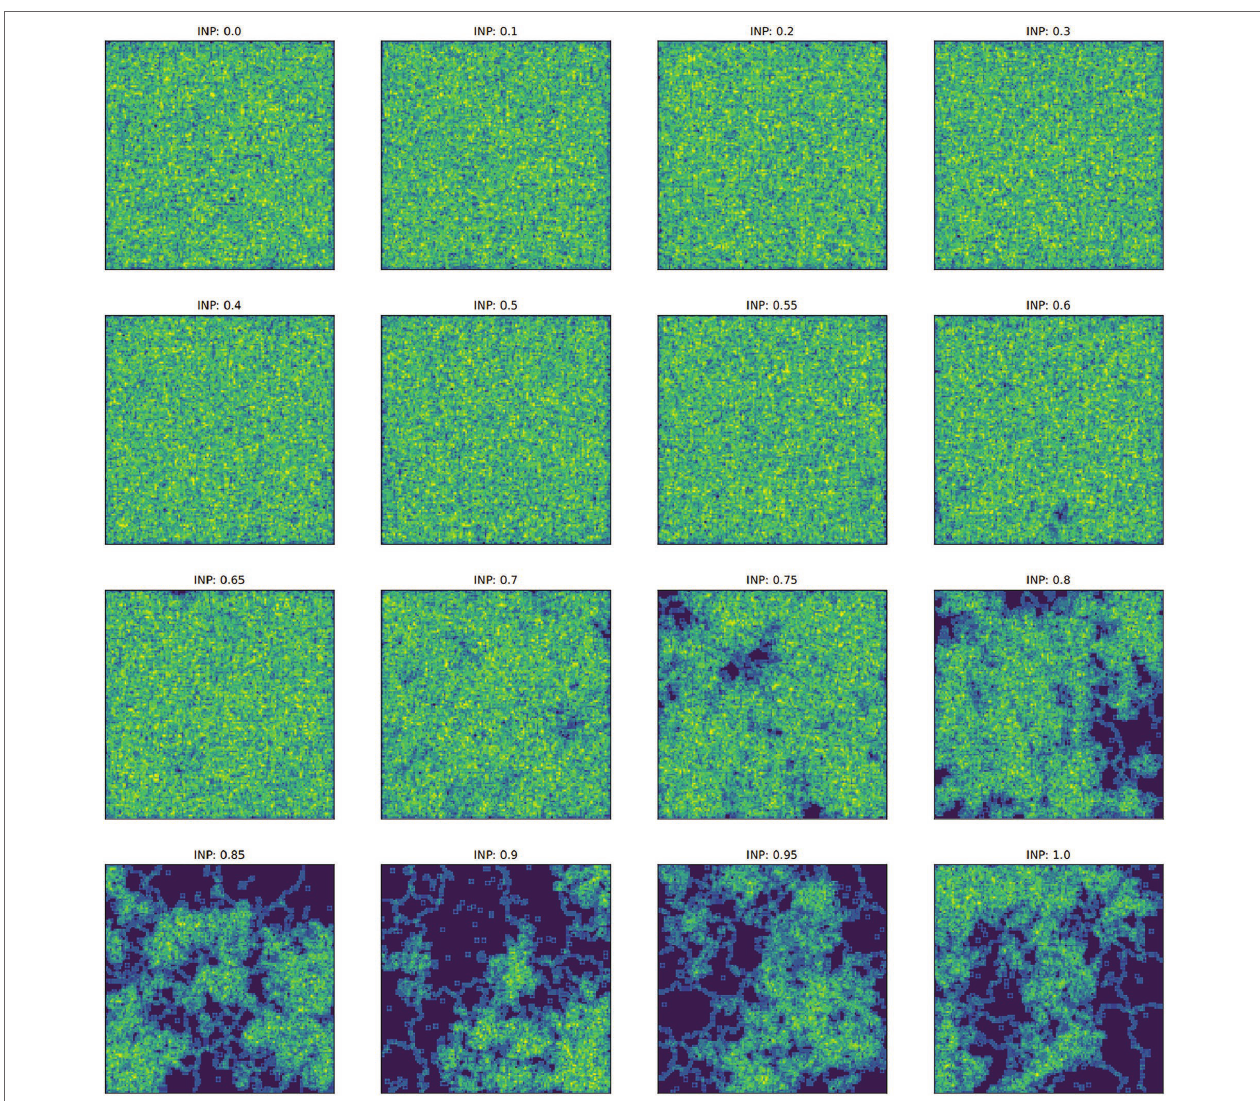
FIGURE 5 | Examples of the final culture matrix for each ideal neighbor proportion (INP) after 4,000 iterations. The Sobel operator produces greater values in regions of higher cultural diversity (yellow and light green) and lower values in regions of homogeneous culture (dark blue). Note that for higher INP, cultural conformity is selected for, but individuals with novelty preference can exist in relatively large numbers, depending on their starting frequency ( Figure 1B